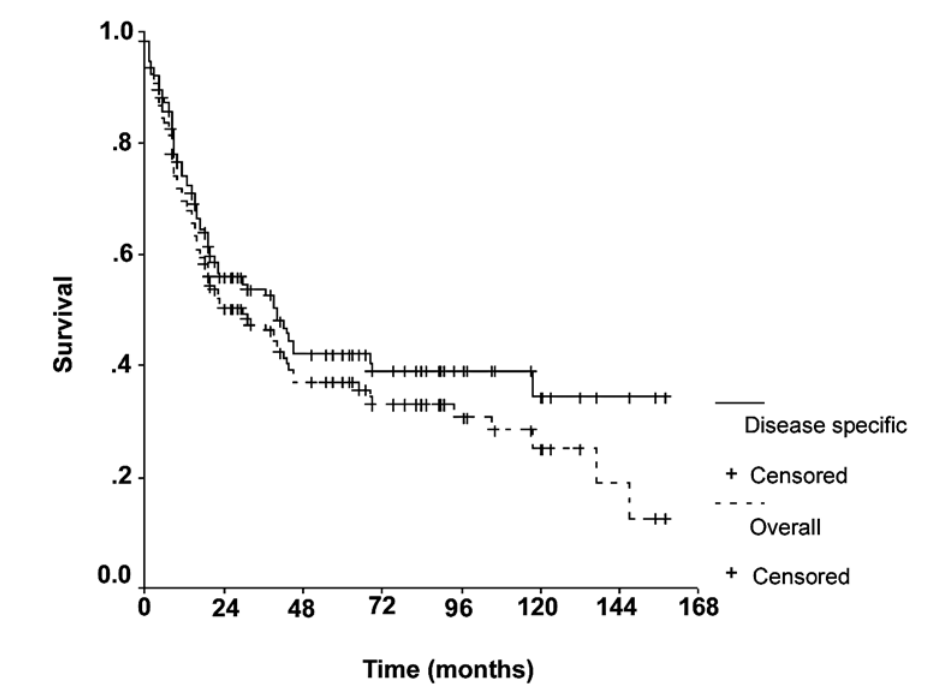
Figure 1 – Overall and disease specific survival curves.